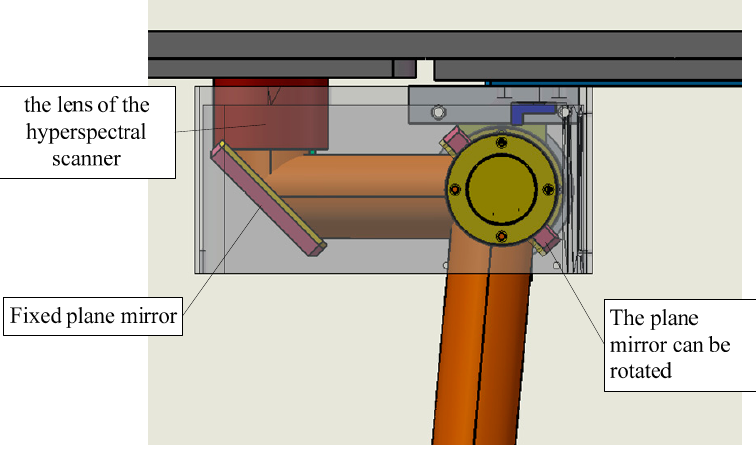
Figure 1. The optical structural design map of the multi-angular hyperspectral module (MAM).